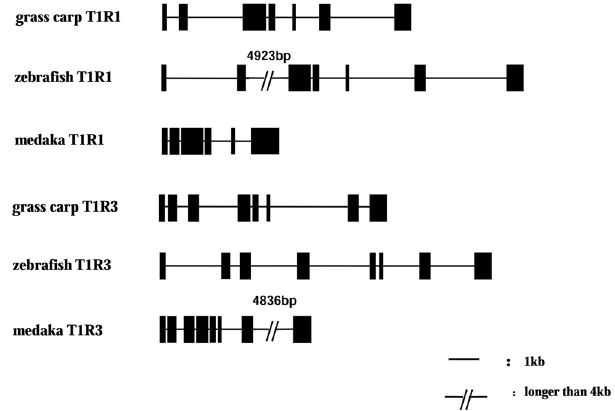
Figure 4. The gene structures of T1R1 and T1R3 genes in grass carp, zebrafish and medaka. The black lines indicate introns and the black boxes indicate exons. Grass carp and zebrafish T1R1 genes contain 7 exons and 6 introns. However, medaka T1R1 has only 6 exons and 5 introns, and the last intron is lost compared with grass carp and zebrafish. Grass carp, zebrafish and medaka T1R3 genes all contain 8 exons and 7